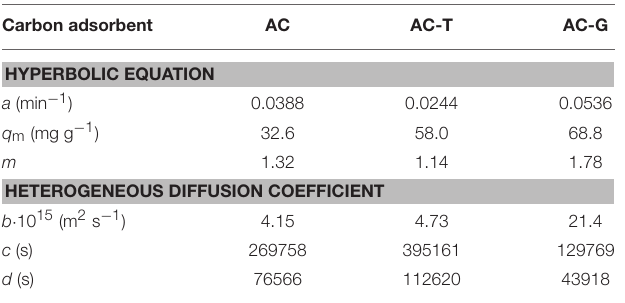
TABLE 4 | Hyperbolic equation and heterogeneous diffusion coefficient parameters obtained from the kinetic study.